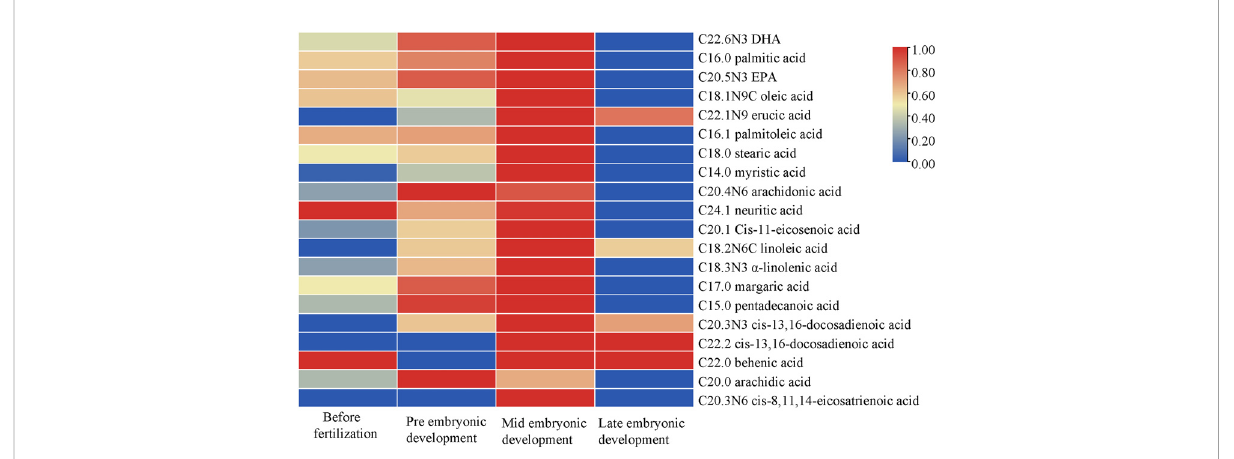
FIGURE 3 Changes in fatty acid contents during different developmental stages. The abscissa represents the time sequence of development, respectively before fertilization, pre embryonic development, mid embryonic development and late embryonic development and the ordinate represents the changes in plasma composition of fatty acids at different development stages.